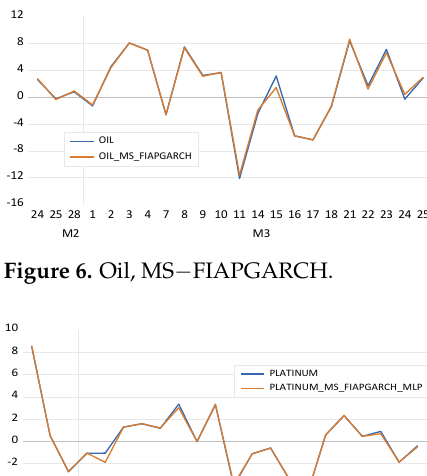
Figure 5. Oil, MS−FIAPGARCH−MLP.